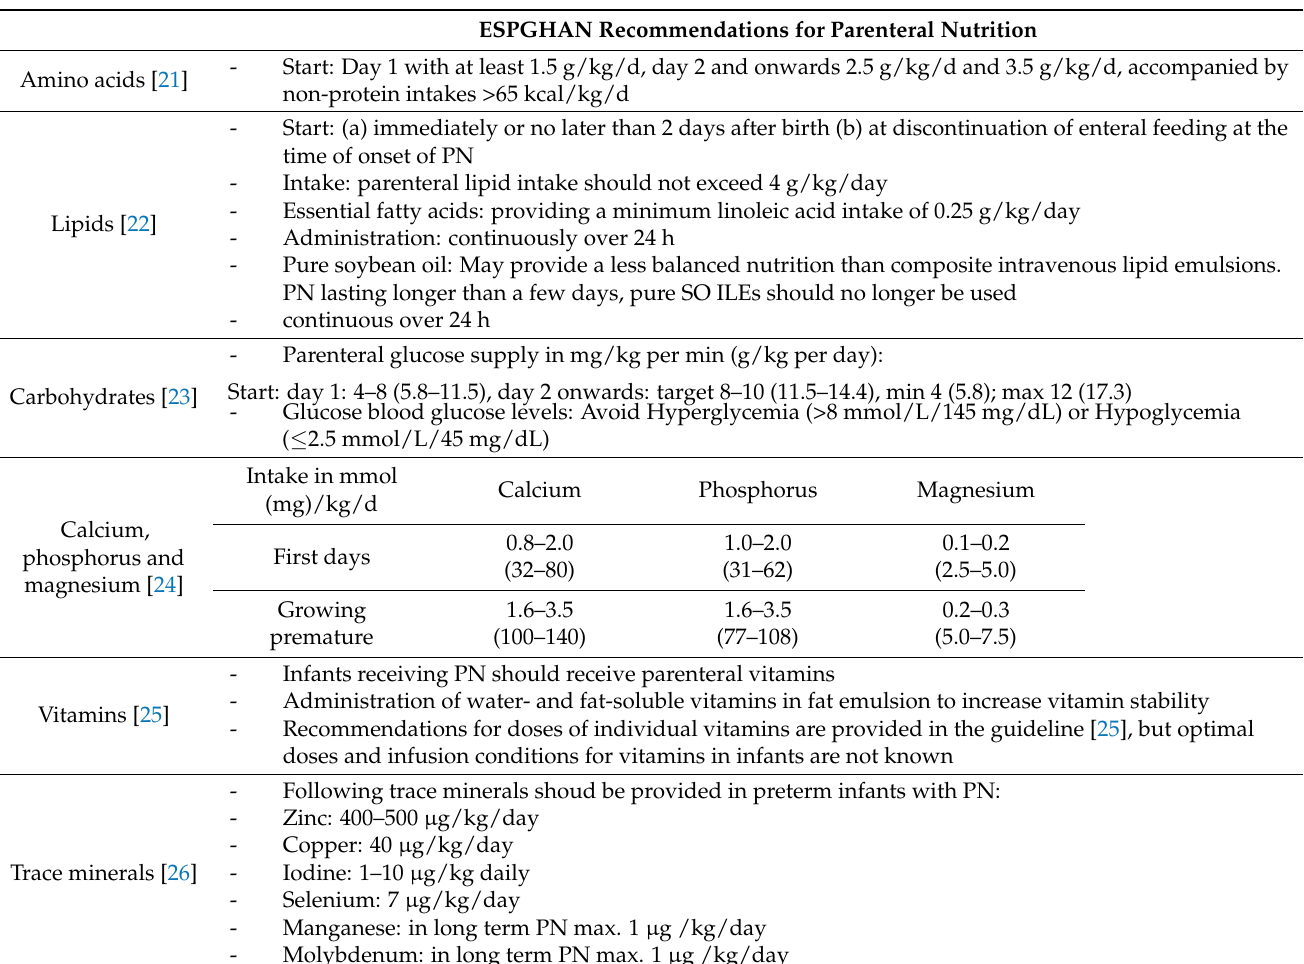
Table 1. Summary of recommendations for postnatal parenteral nutrition in preterm infants according to the ESPGHAN guideline